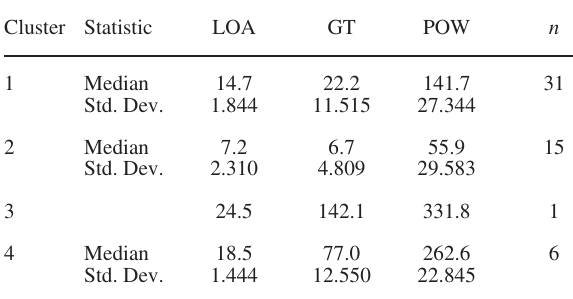
Table 2. – descriptive statistics of vessel technical characteristics by the four clusters selected using the data from both fleets. loa, length-over-all; gt, gross tonnage; PoW, engine power.